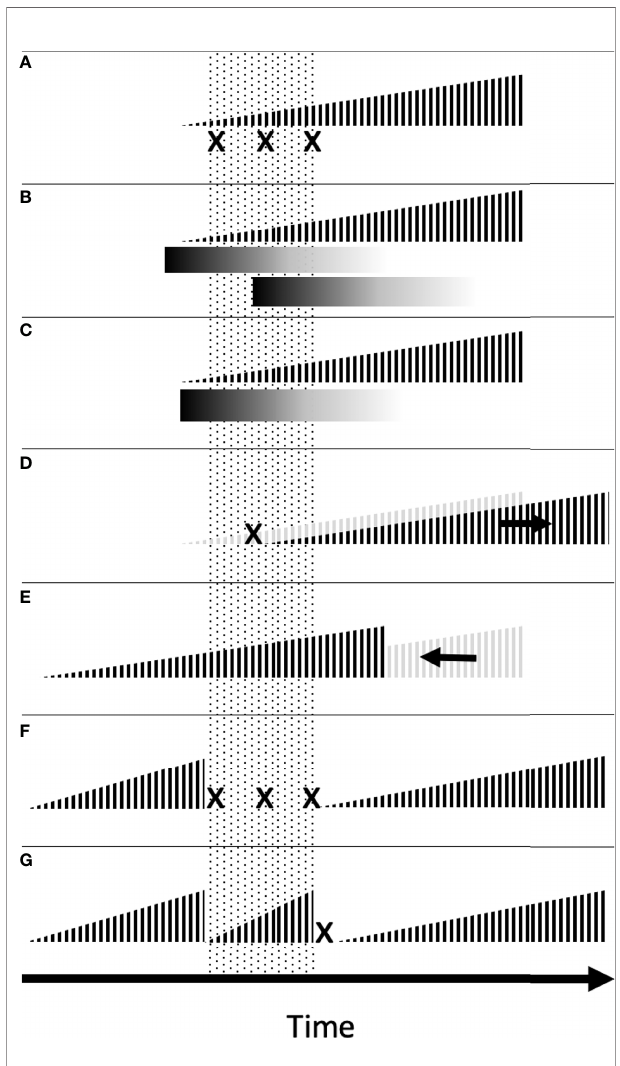
FIGURE 3 | Depiction of tactics that may be used to target a hypothetical weed emergence peak (dotted area) occurring shortly after the typical crop planting. If the planting date or crop rotation is not fl exible, frequent control of weed seedlings (A) , overlapping residual herbicide applications (B) , establishment of residue mulch (C) , or some combination thereof may be used to target the peak emergence period. If the planting date or crop rotation are fl exible, the peak emergence period may be targeted by delaying planting to allow pre-plant control of part of the fl ush (D) , planting early at high density to expedite crop canopy closure (E) , or adjusting rotation to allow for a bare fallow (F) or short-duration crop that concludes prior to weed seed production (G) . Height of vertical bars represents the relative crop maturity. Physical or chemical weed seedling control actions are symbolized with an “ x. ” Gradients represent the breakdown of residual herbicides or residue mulch over